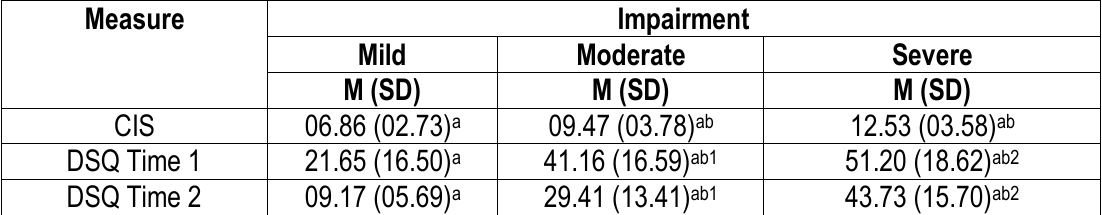
Table 4. Summary statistics for the CIS and DSQ at two time points